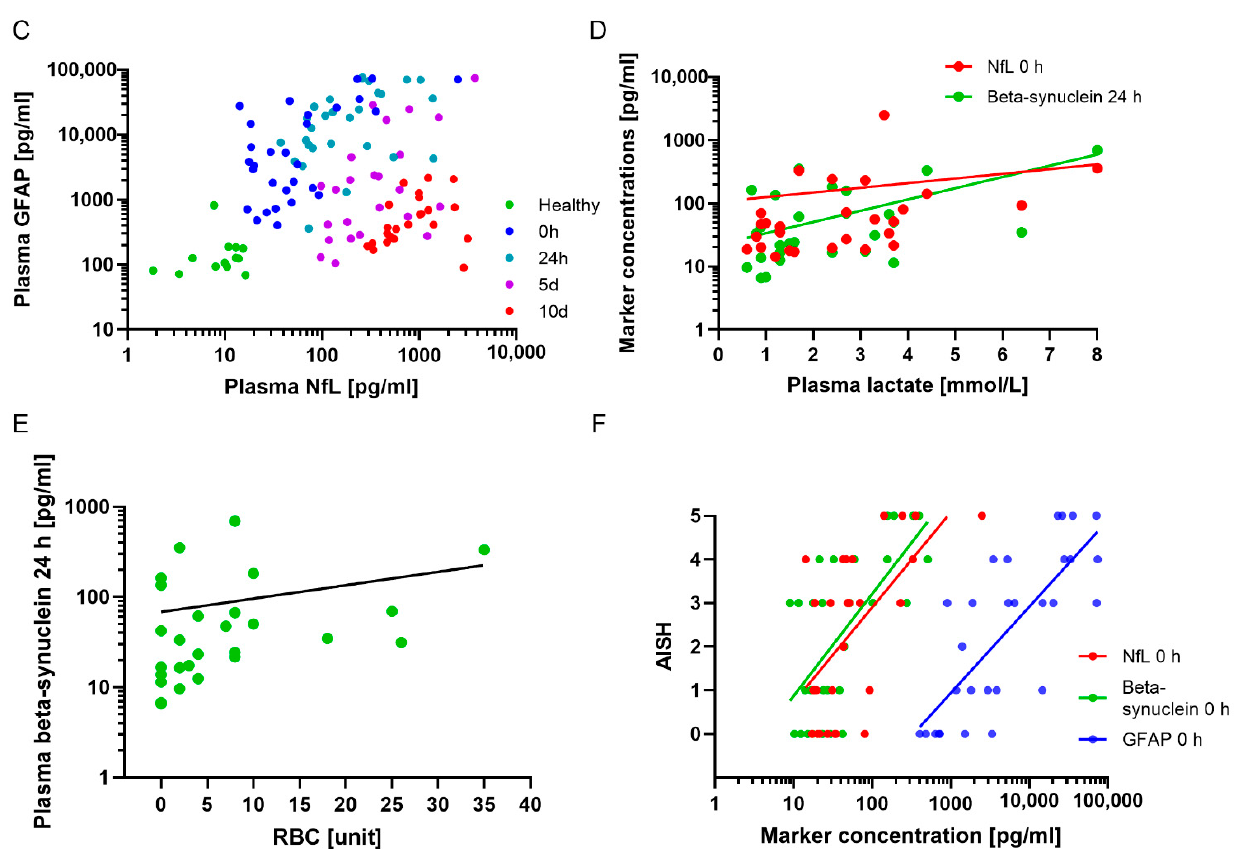
Figure 2. Correlations between markers and clinical scores. ( A – C ) Correlations between neurological markers in the trauma cohort; healthy controls are shown as a reference. Beta-synuclein and NfL ( A ) (r = 0.16 (CI: − 0.04–0.35), p = 0.1) and GFAP ( B ) (r = 0.63 (CI: 0.50–0.74), p < 0.0001) as well as NFL and GFAP ( C ) (r = − 0.10 (CI: 0.29–0.10), p = 0.3), with color coded time points, respectively. Individual r and p values for the different times can be found in Supplementary Table S1. N = 117 for ( A – C ). ( D ) Correlation between plasma lactate assessed in the shock room and NfL (r = 0.47 (CI: 0.10–0.72), n = 28, p = 0.01) and beta-synuclein (r = 0.40 (CI: 0.01–0.68), n = 27, p = 0.03) at 0 h and 24 h, respectively. ( E ) Correlation between the applied RBC units and plasma beta-synuclein at 24 h (r = 0.45 (CI: 0.07–0.71), n = 27, p = 0.02). ( F ) Correlation analysis of the AISH with all three neurological plasma markers 0 h postadmission (NfL (r = 0.56 (CI: 0.24–0.77), n = 29, p = 0.0015), beta-synuclein (r = 0.63 (CI: 0.33–0.81), n = 29, p = 0.0003), and GFAP (r = 0.80 (CI: 0.61–0.91), Supplementary Table S1. Correlation analysis was performed using Spearman´s rank correlation coefficient. Lines represent nonlinear regression. AISH, abbreviated injury score head; GFAP, glial fibrillary acidic protein; NfL, neurofilament light chain; RBC, red blood cell concentrates.